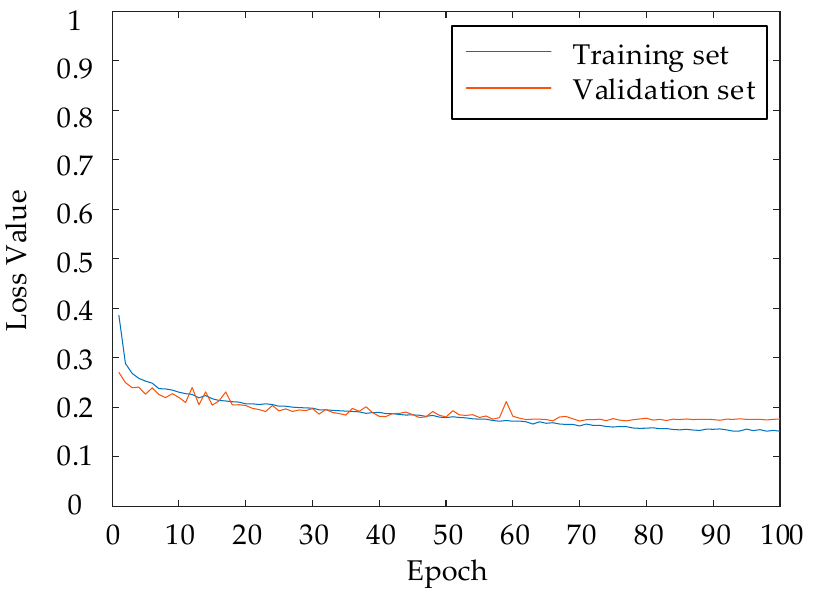
Figure 9. Curves for training and validation loss.